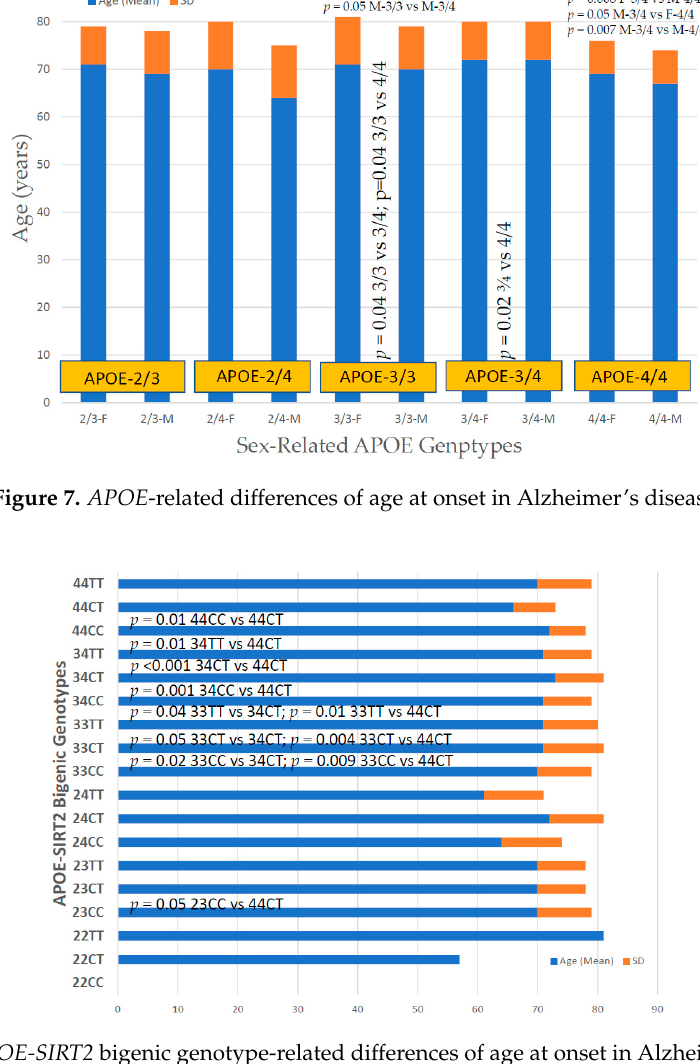
Table 2. SIRT2-related phenotypes in patients with Alzheimer’s disease.